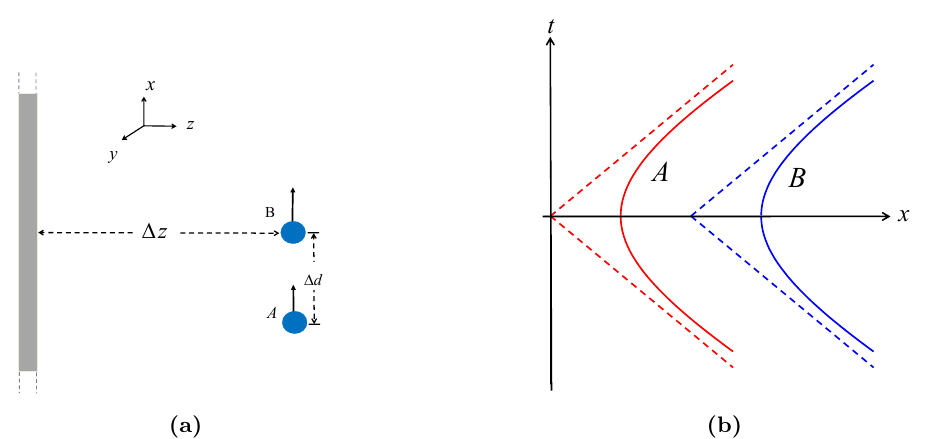
Figure 5. In the case of parallel acceleration, two uniformly accelerated detectors with a separation ∆ d are aligned parallel to the boundary plane at a distance ∆ z away from the boundary in (a), the worldlines of such two accelerated detectors are depicted respectively in (b). Here, the black arrows indicate the direction of